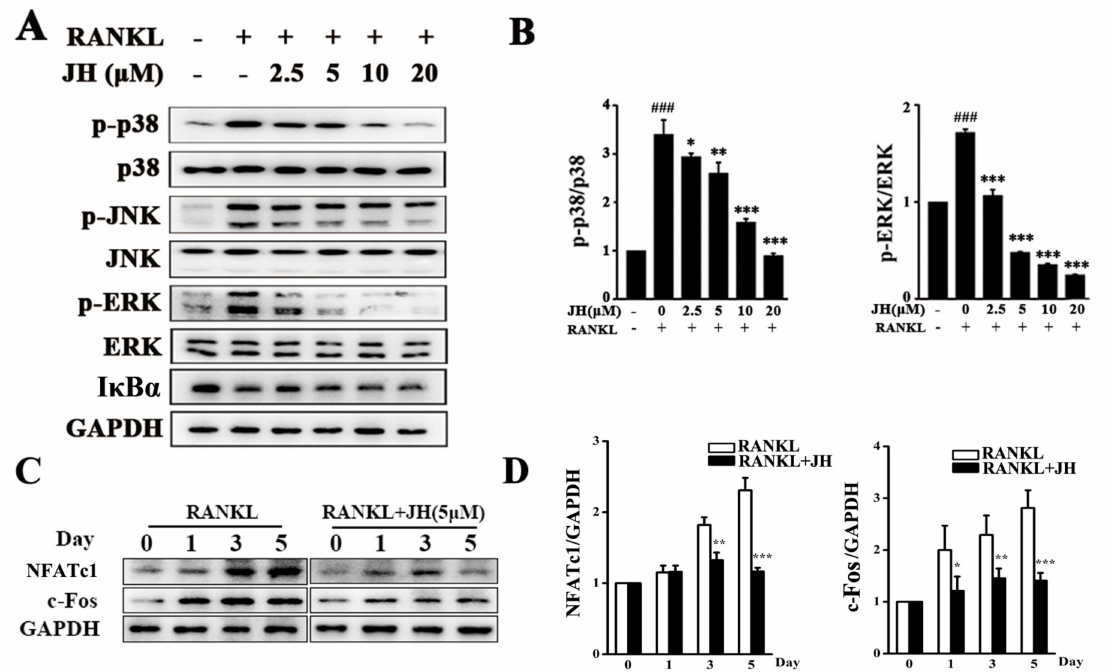
Figure 6. JH attenuates RANKL-stimulated activations of MAPKs (p38 and ERK). ( A , C ) After pretreatment with or without JH for 1 h, BMM cells were stimulated with RANKL (100 ng · mL − 1 ) for 15 min in ( A ), and 0, 1, 3, 5 days in ( C ). Western blotting was performed to examine the levels of p-p38, total p38, p-ERK1/2, total ERK1/2, p-JNK, total JNK, I κ B α , NFATc1, c-Fos and GAPDH. ( B , D ) The ratios of p-p38/p38, p-ERK/ERK, NFATc1/GAPDH and c-Fos/GAPDH were quantified and calculated using ImageJ software ( n = 3). All data were shown as mean ± SD; * p < 0.05, ** p < 0.01 and *** p < 0.001 relative to RANKL-treated, JH-untreated controls. ### p < 0.001 relative to RANKL-untreated, JH-untreated